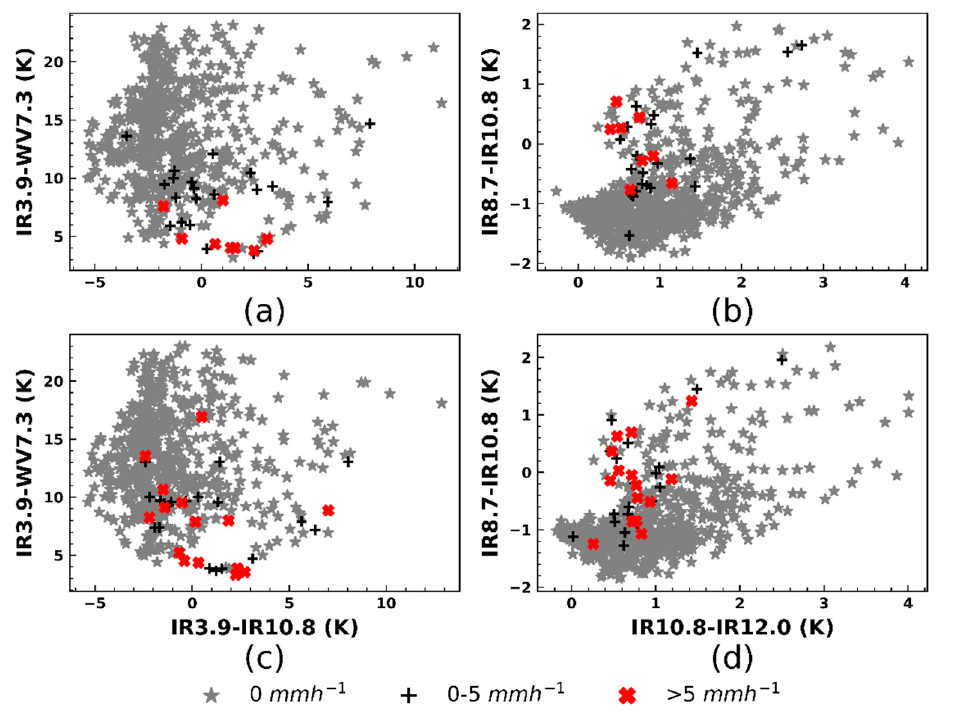
Figure 8. Nighttime R RG ( a , b ) and R MWL ( c , d ) as a function of ∆ T IR3.9-IR10.8 versus ∆ T IR3.9-WV7.3 , ( a , c ) and ∆ T IR10.8-IR12.0 versus ∆ T IR8.7-IR10.8 ( b , d ) for Naivasha. (ii) Inferences from analyzing rainfall estimates with MSG satellite